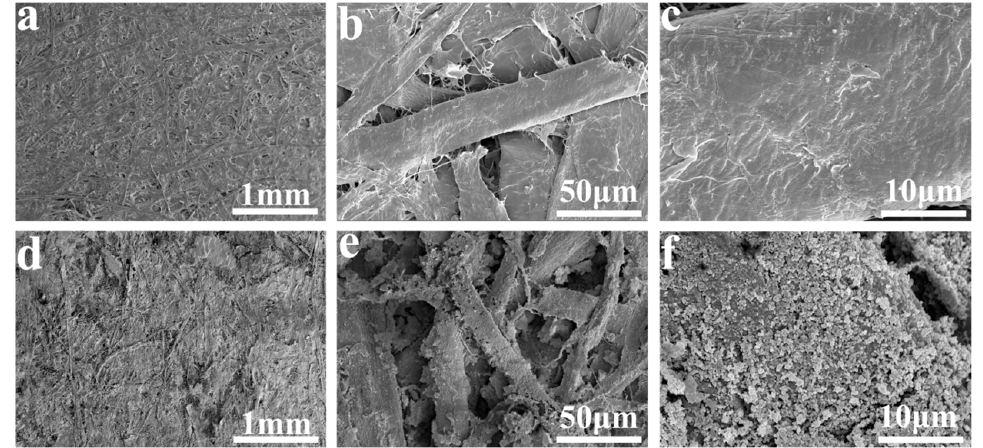
Figure 3. ( a ) SEM images of base paper mulching film surface, ( b ) SEM images of base paper mulch ‐ ing film fiber, ( c ) SEM images of base paper mulching film fiber, ( d ) SEM images of coated paper mulching film surface, ( e ) SEM images of coated paper mulching film fiber, ( f ) SEM images of coated paper mulching film fiber.